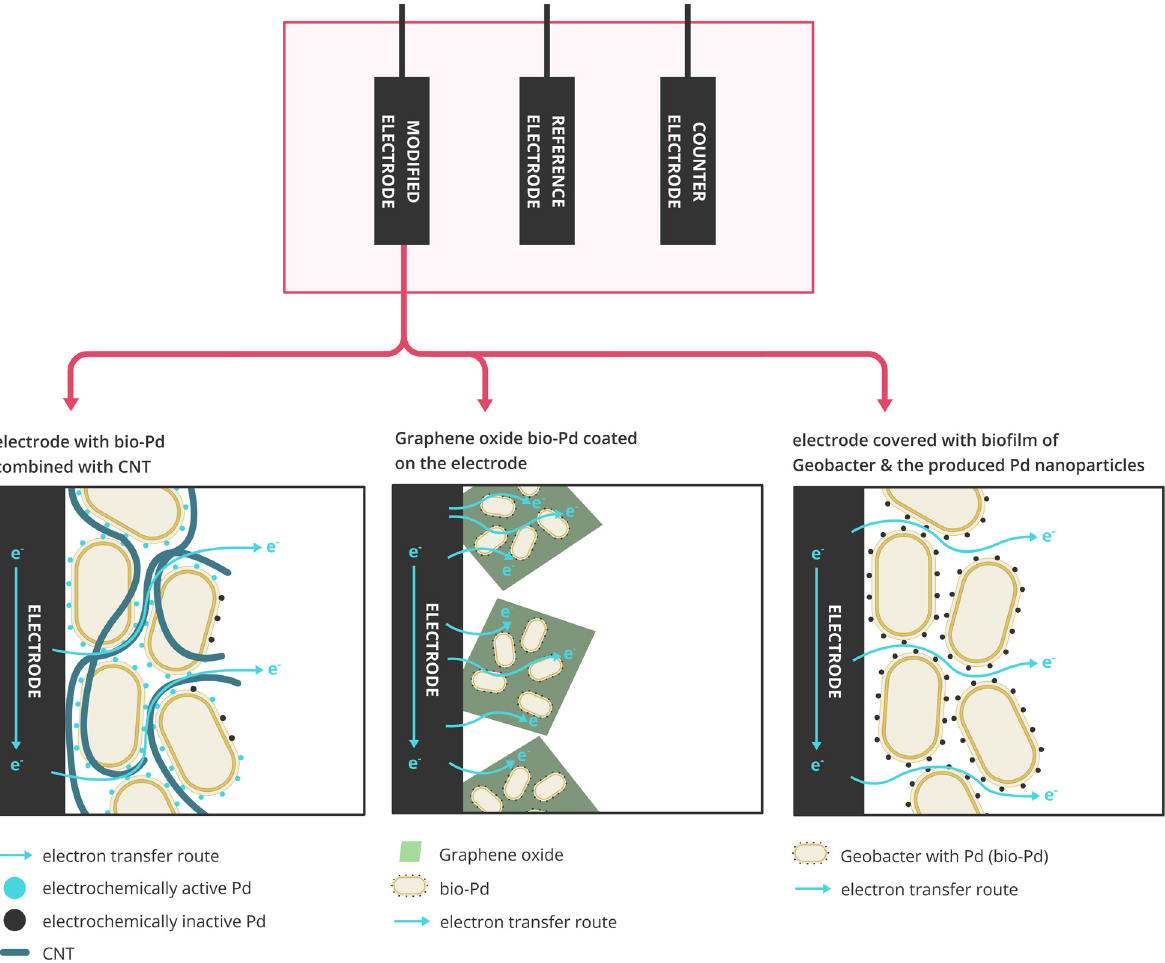
Figure 4: Fixing bio - Pd on an electrode, to increase the conductivity in a 3 – electrode system through CNT, graphene oxide, and bio fi lm production by Geobacter . The fi gure was adapted from Hou et al. [ 126 ] , Cheng et al. [ 46 ] , and Hou et al. [ 125 ]